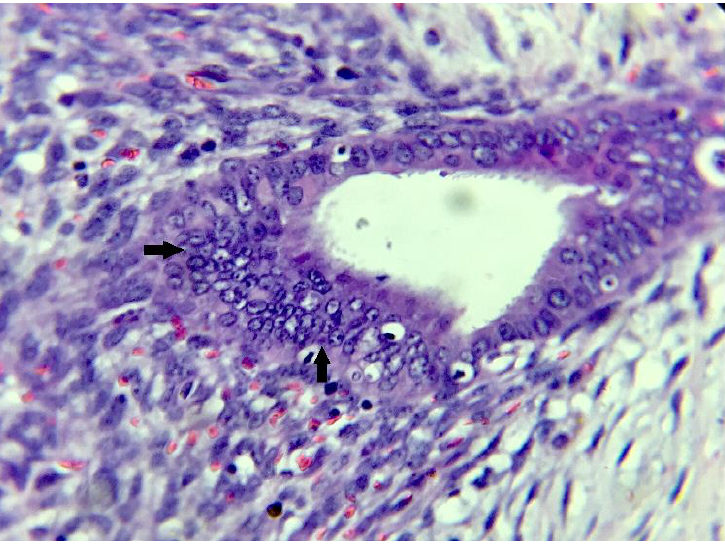
Figure 6. Endometrial gland with